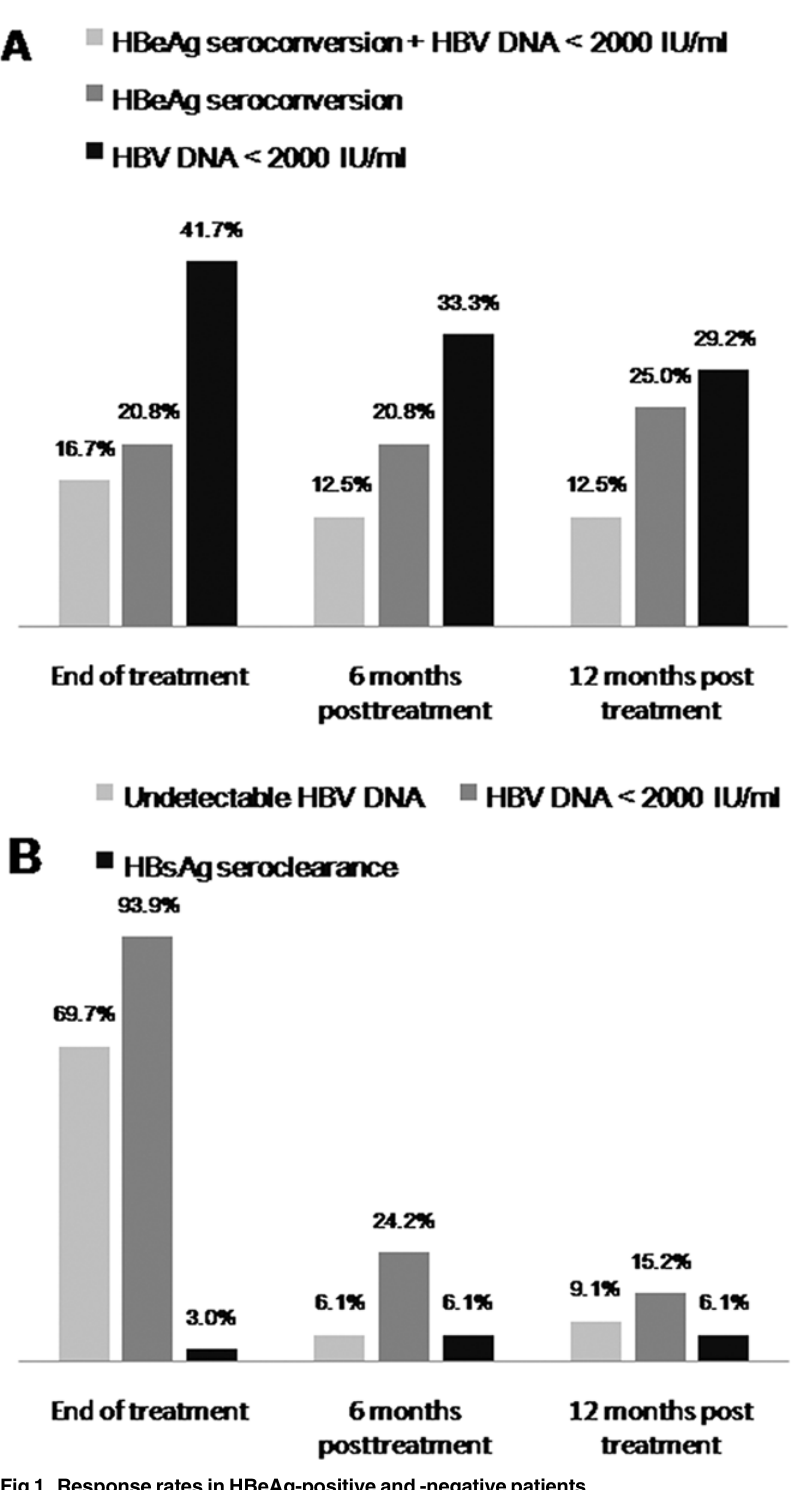
Fig 1. Response rates in HBeAg-positive and -negative patients.